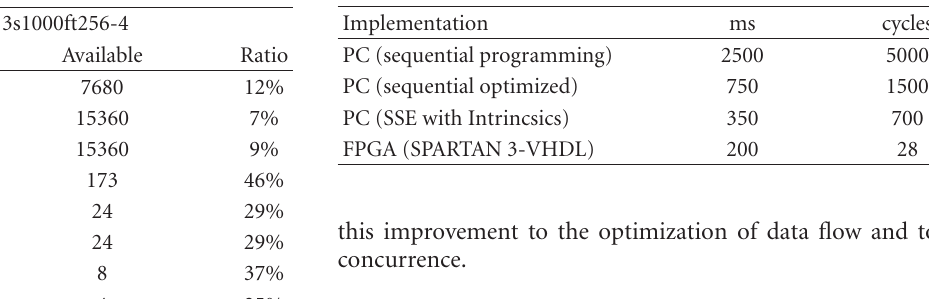
Table 2: Summary of resources usage.